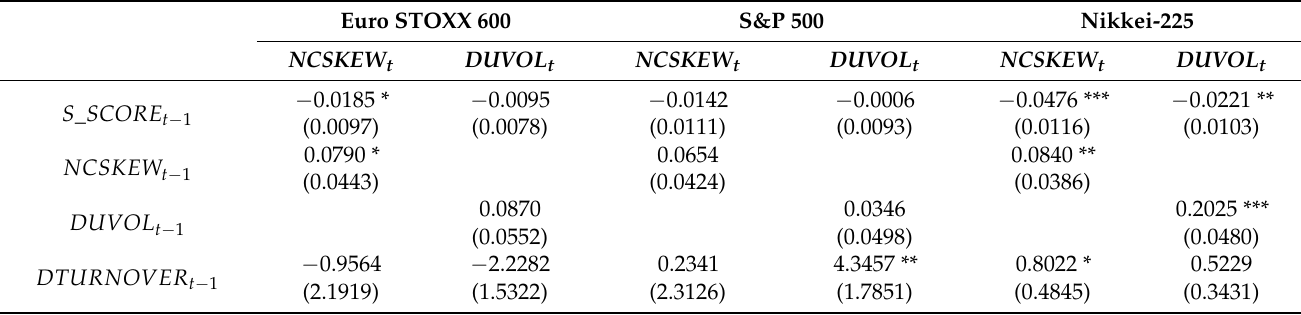
Table 8. Regression analysis on the effect of social disclosure on crash risk using dynamic panel